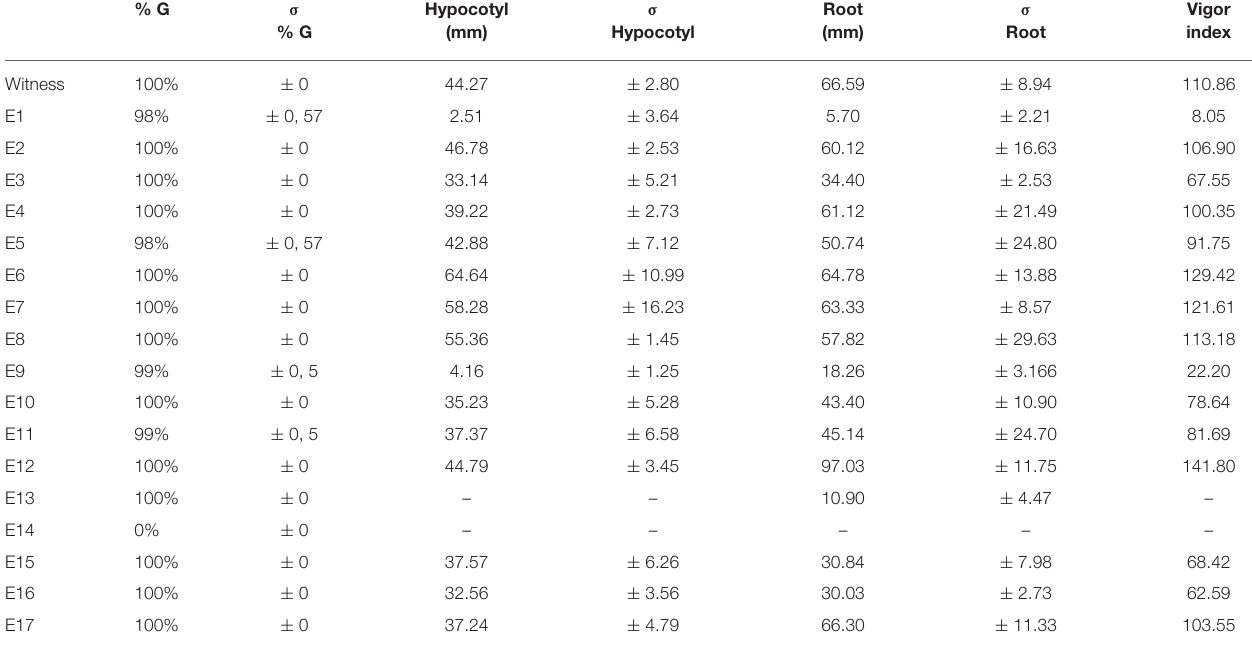
TABLE 5 | Germination tests in Cucumis sativus seeds with liquid biocompounds produced in design of experiments (CCRD 2 3 ) after 8 days of application. % G